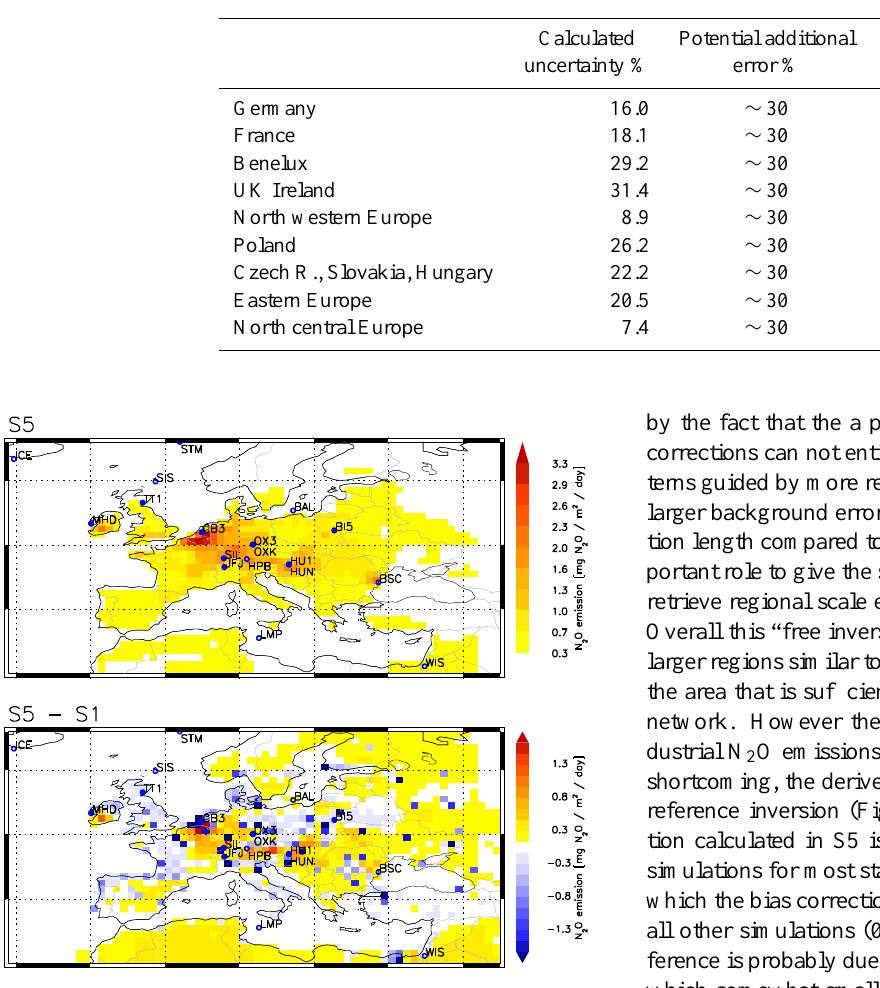
Table 7. Uncertainty estimates for derived emissions (annual total emissions; 2 σ ). The ‘calculated uncertainties’ are based on the a posteriori uncertainties (evaluated with the conjugate gradient algorithm) per grid cell and month, aggregated to annual uncertainties per country, taking into account the spatial and temporal correlations. The Potential additional model errors are estimated as the ensemble standard deviation from a preliminary model comparison performed within the NitroEurope IP project. The overall uncertainty is computed as the square root of the sum of the squared errors.